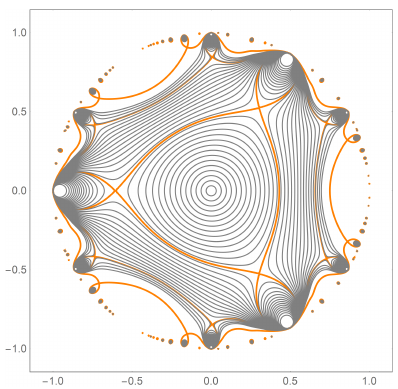
Figure 20. The first, second, and third separatrixes for the case of L ( C ( 3 ) ; z ) and N = 32 are shown in orange and are superimposed on the contour plot. The value of the level sets occur at approximately | f ( z ) | = 0.4645,0.8620, and 1.1275, respectively. 32 Table 1. “Exact” values of ρ S and corresponding the separatrix level set value, for the first and second i separatrix. The “exact” values were calculated using the N = 32 member of each lacunary sequence.